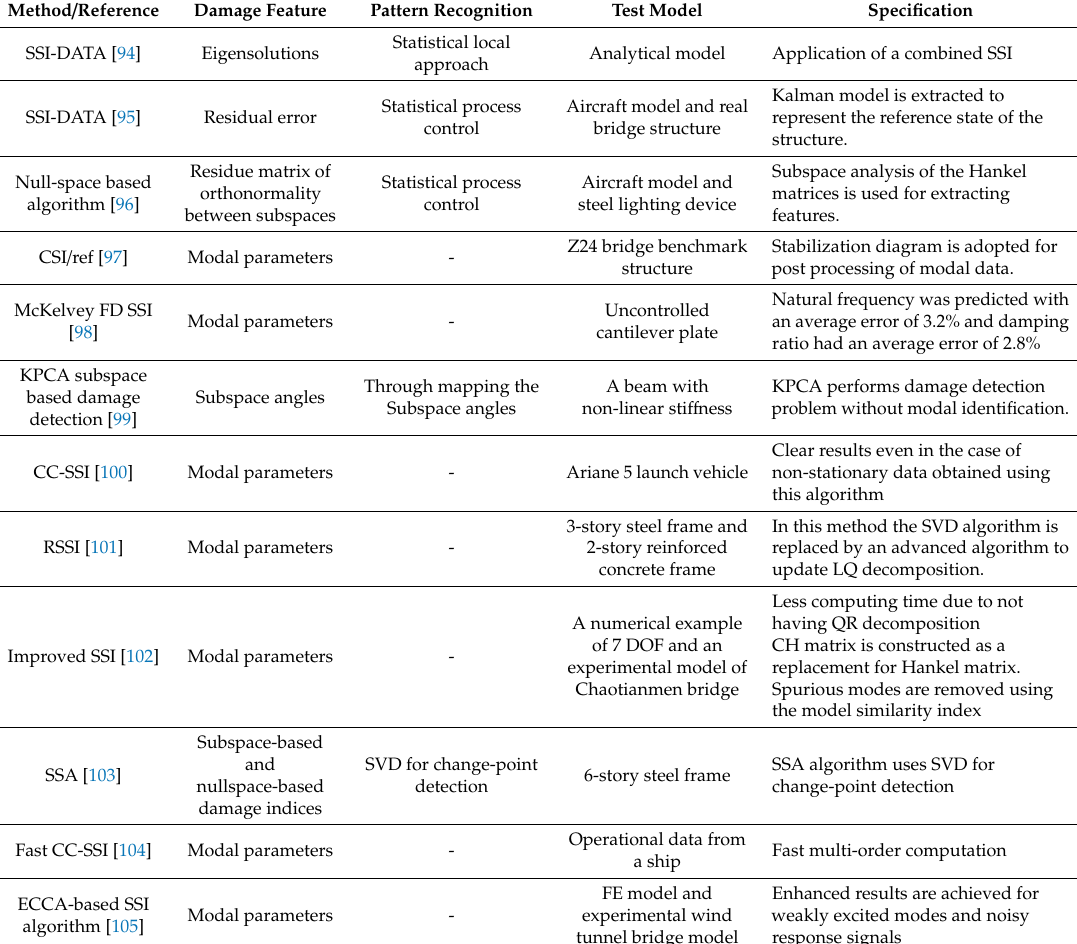
Table 3. Some examples of schemes that use data-driven subspace system identification (SSI-DATA) in their damage identification